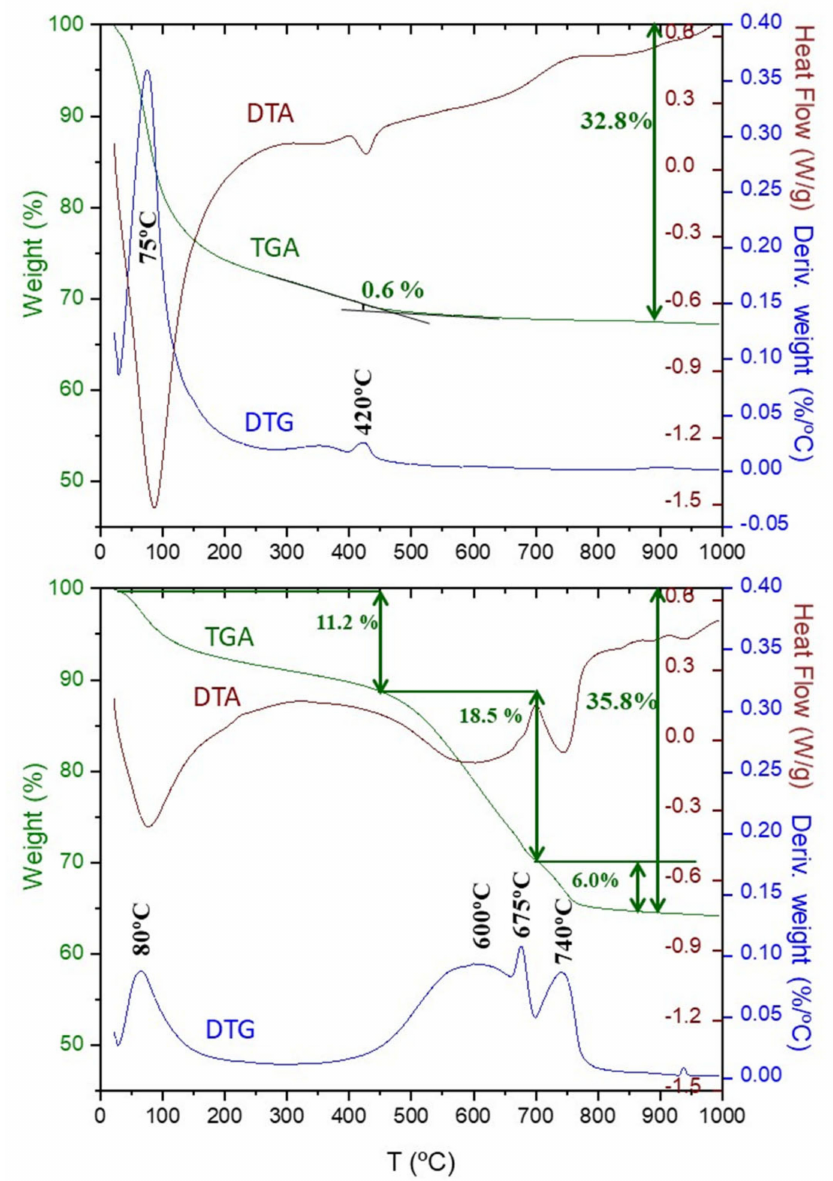
Figure 11. Thermal analysis traces as in Figure 9 for ( a ) C 2 S_hyd and ( b ) C 2 S_carb. For C 2 S_hyd, the reported weight losses 0.6 and 32.8% were calculated from the slope method centred at 420 ◦ C (to correct from the C-S-H contribution at these temperatures) and RT–900 ◦ C, respectively.